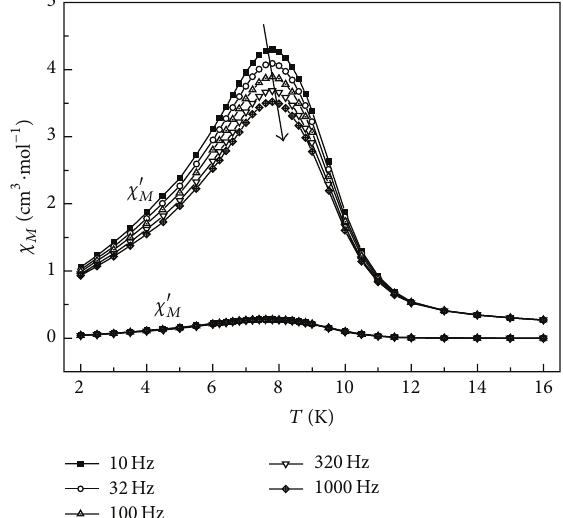
Figure 9: ZFC and FC magnetization curves with different field. the field-cooled (FC) magnetization curves below 𝑇 𝐶 = 12 K.